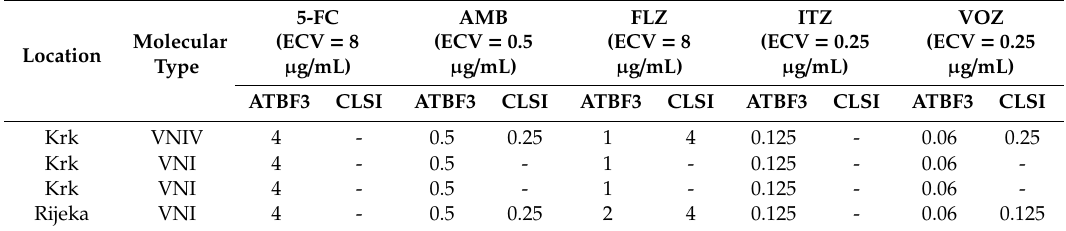
Table 1. Antifungal susceptibility of the four C. neoformans species complex isolates tested by ATB FUNGUS 3 and broth microdilution reported as minimal inhibitory concentration values ( µ g /